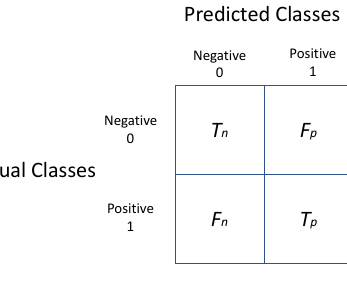
Figure 27. Confusion Matrix Structure.